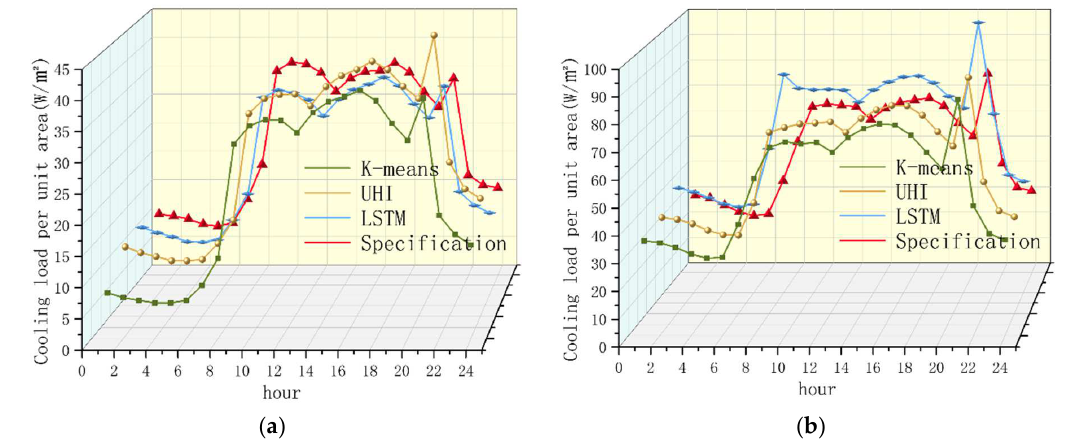
Figure 16. The unit area of outpatient buildings in Beijing ( a ) and Shanghai ( b ) is subjected to hourly cooling load.